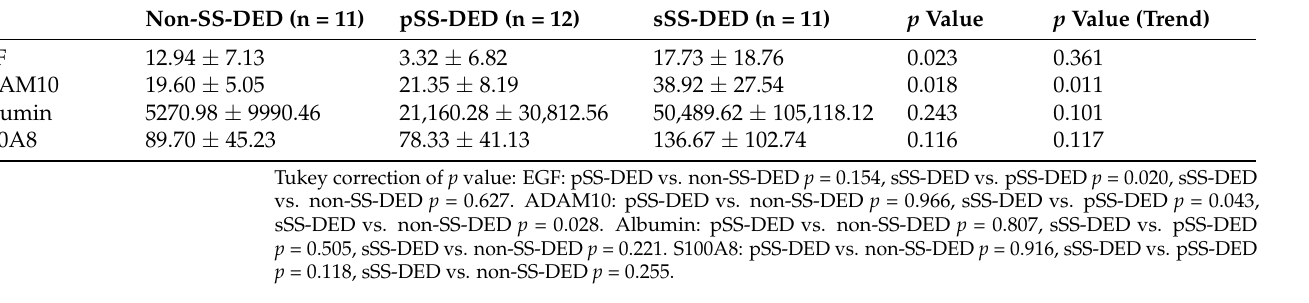
Figure 4. Connections and interactions identified between the 29 candidate proteins using Ingenuity Pathway Analysis. Individual nodes are hidden.